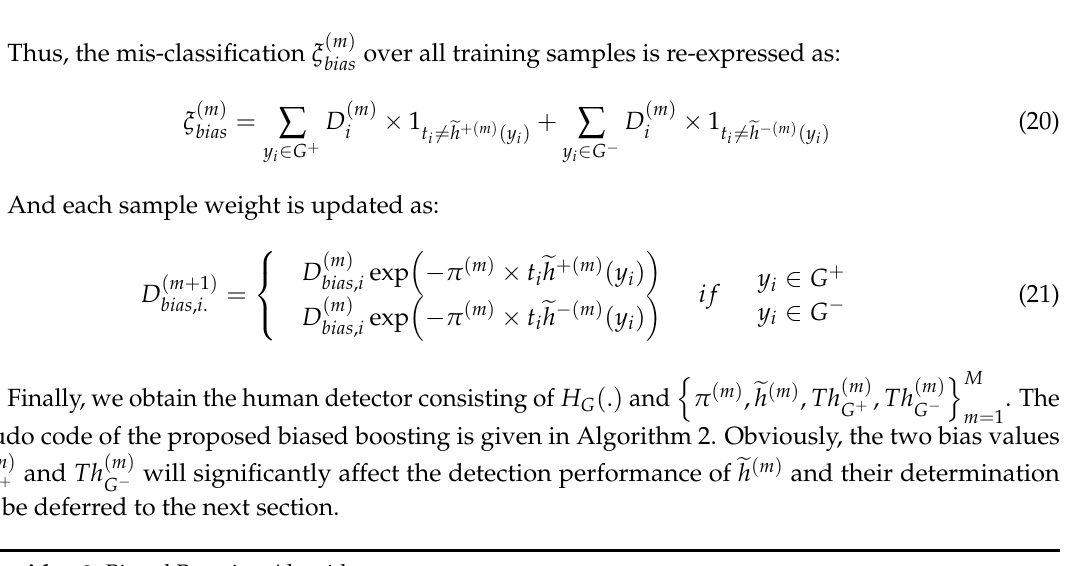
Algorithm 2: Biased Boosting